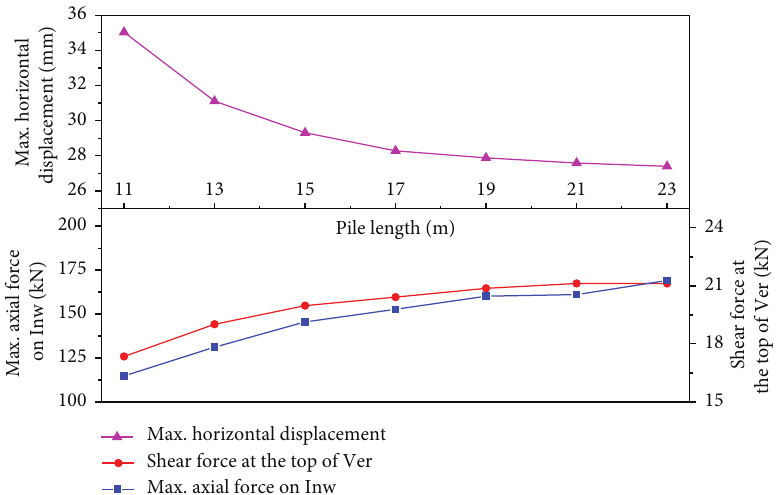
Figure 23: Comparison of maximum horizontal displacement, maximum axial force, and shear force of VIIP with different lengths of inward-inclined piles.